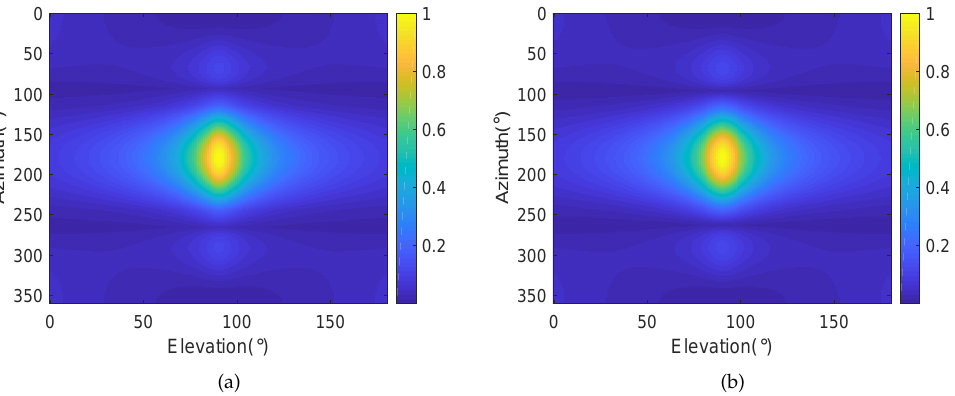
Figure 13. Normalized frequency invariant beampatterns at f = 400 Hz and f = 900 Hz . ( a ) f = 400 Hz ; ( b ) f = 900 Hz